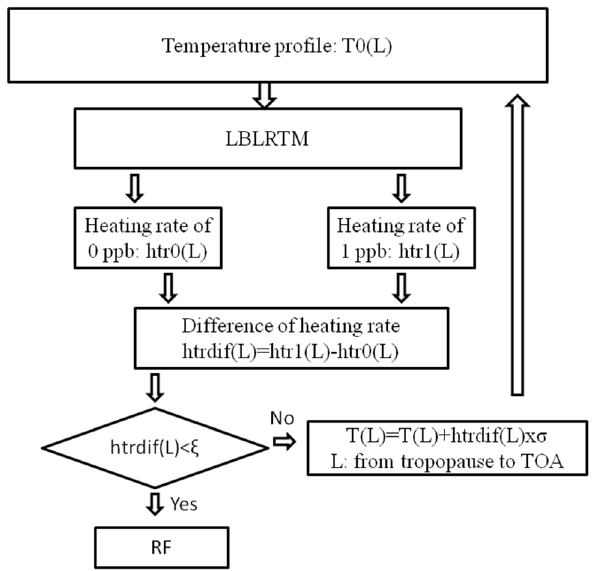
Figure 3. Schematic of stratospherically adjusted radiative forcing is shown. (L denotes the layer number, T0 is the old temperature profile, T is the new temperature profile, htr0 is the heating rate with no NF 3 , htr1 is the heating rate with the NF 3 of 1 ppb, htrdif is the difference between htr1 and htr0, ξ is the convergence value, and σ is a multiple of htrdif. RF is radiative forcing. Here, the value of σ is 5).